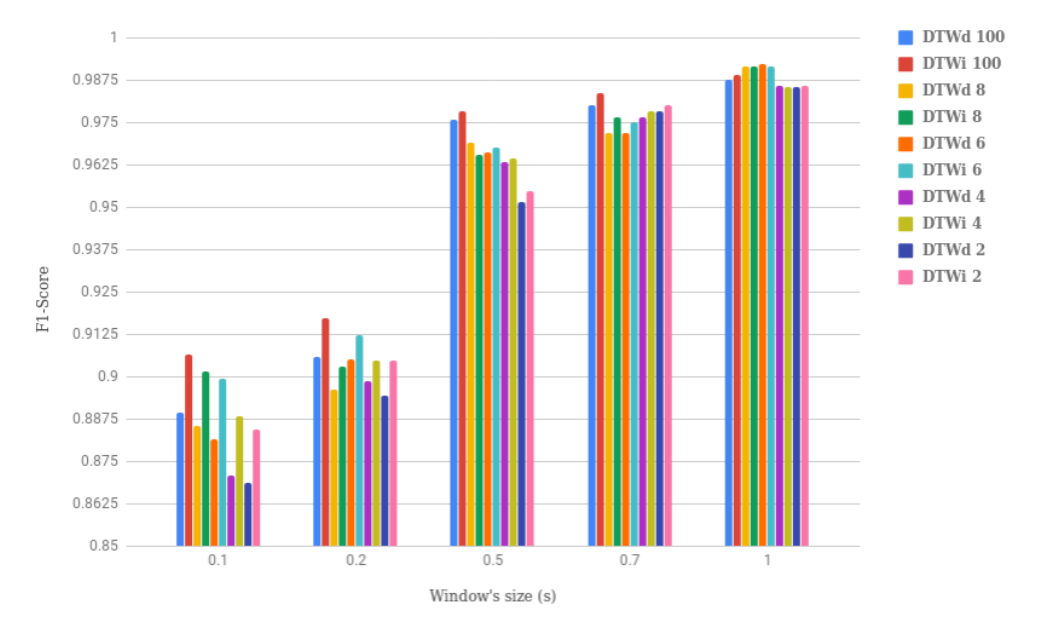
Figure 7. F1-score values for the different types of raw data based classification (dependent and independent DTW), sampling window’s size (0.1, 0.2, 0.5, 0.7, and 1.0 s), and percentage of sub-sampling (where 100 means non-sub-sampling). The longer the sampling window, the better the classification performance. Observe how, for our task, a 0.5 s sampling window already provided a very good F1-score.